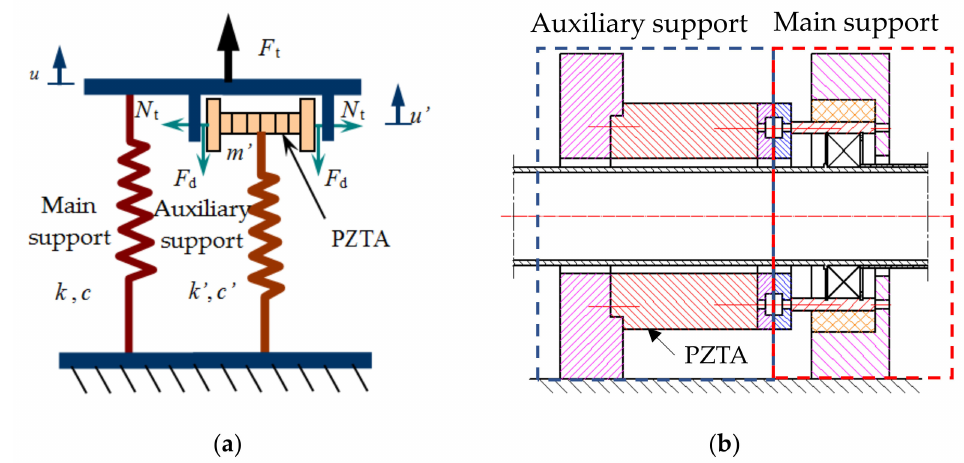
Figure 2. ( a ) Principle sketch and ( b ) structure diagram of Smart